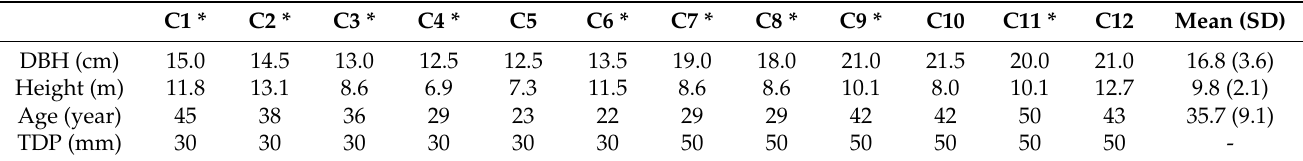
Table 2. Diameter at breast height (DBH), height and age of the control trees and length of the heat dissipation probes (TDP). Chlorophyll fluorescence and gas exchange measurements were made on the trees indicated by an asterisk.